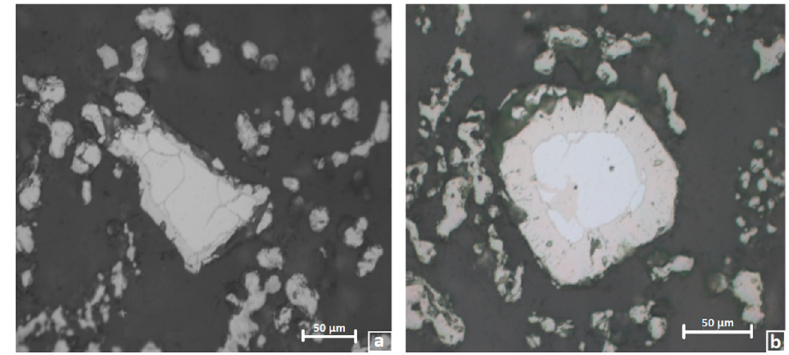
Figure 8. ( a ) Microstructure of particles at the initial stage of nitridation. ( b ) The formation of the Cr 2 N layer. Nitrogen pressure—4 MPa.